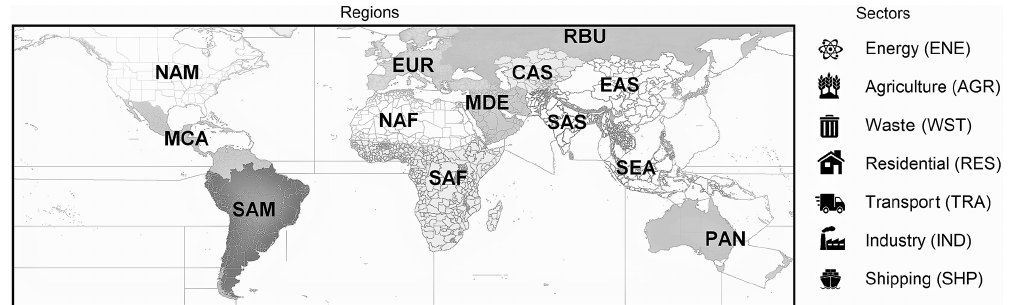
Figure 1. Emission source regions and sectors used in the